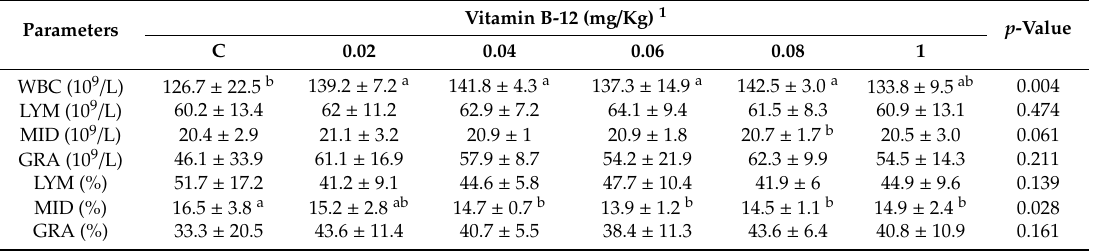
Table 3. E ff ect of dietary vitamin B12 on white blood cell count and its indices in meat-type Pekin ducks (mean ± SD).